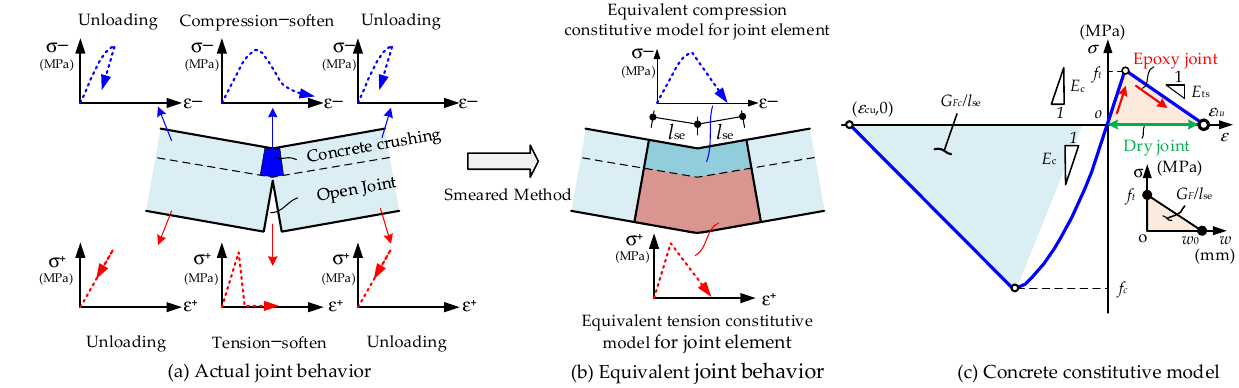
Figure 4. Smeared strain method and concrete constitutive model for joint element.